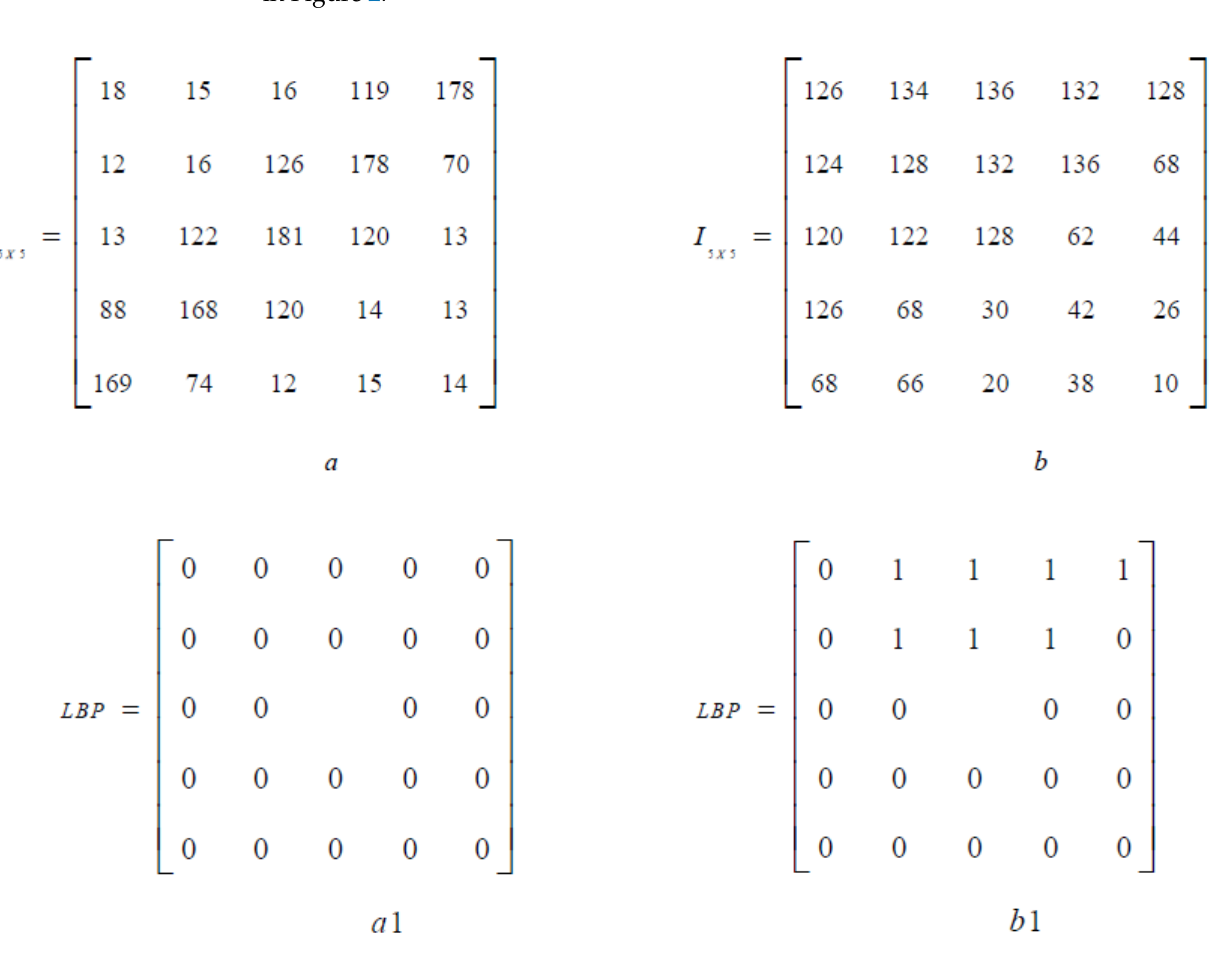
Figure 2. Image patches ( a , b ) and corresponding LBP patterns ( a1 , b1 ).